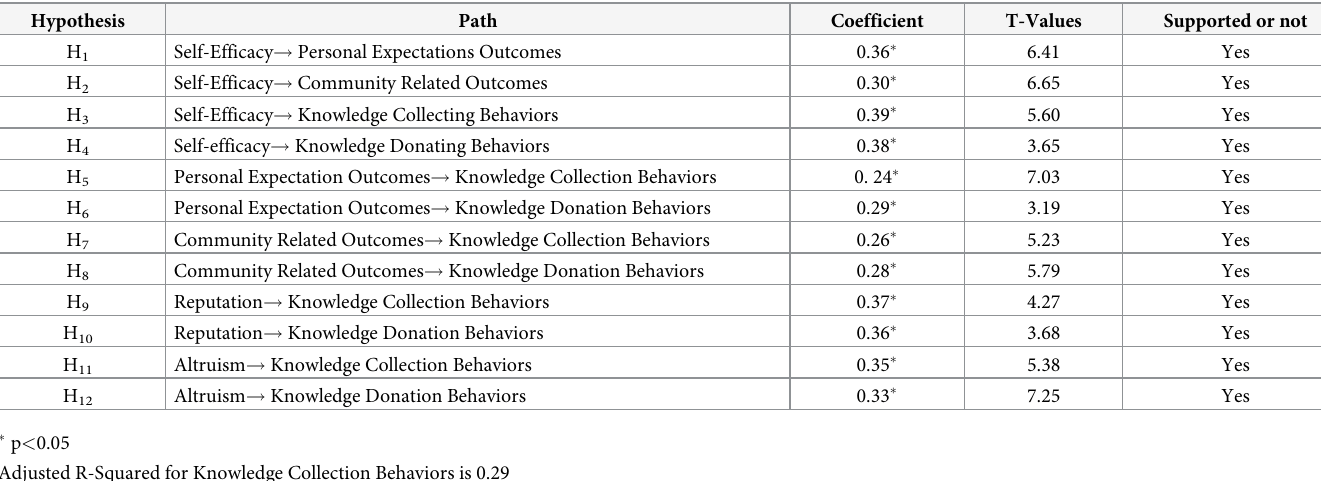
Table 7. Path coefficients and their